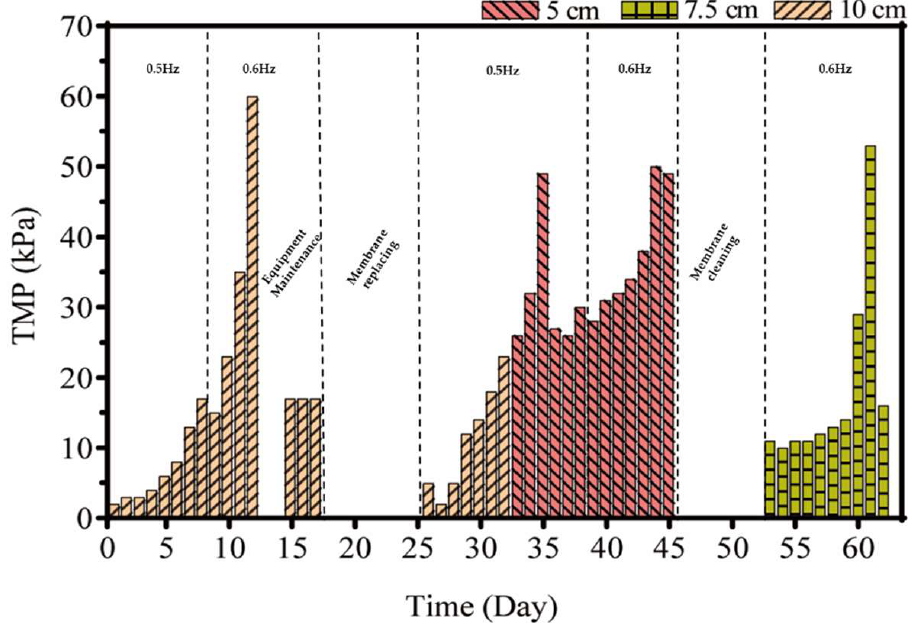
Figure 3. The profile of TMP under different frequencies (0.5 and 0.6 Hz) and amplitudes (5, 7.5, and 10 cm) in LEP-N-MBR.